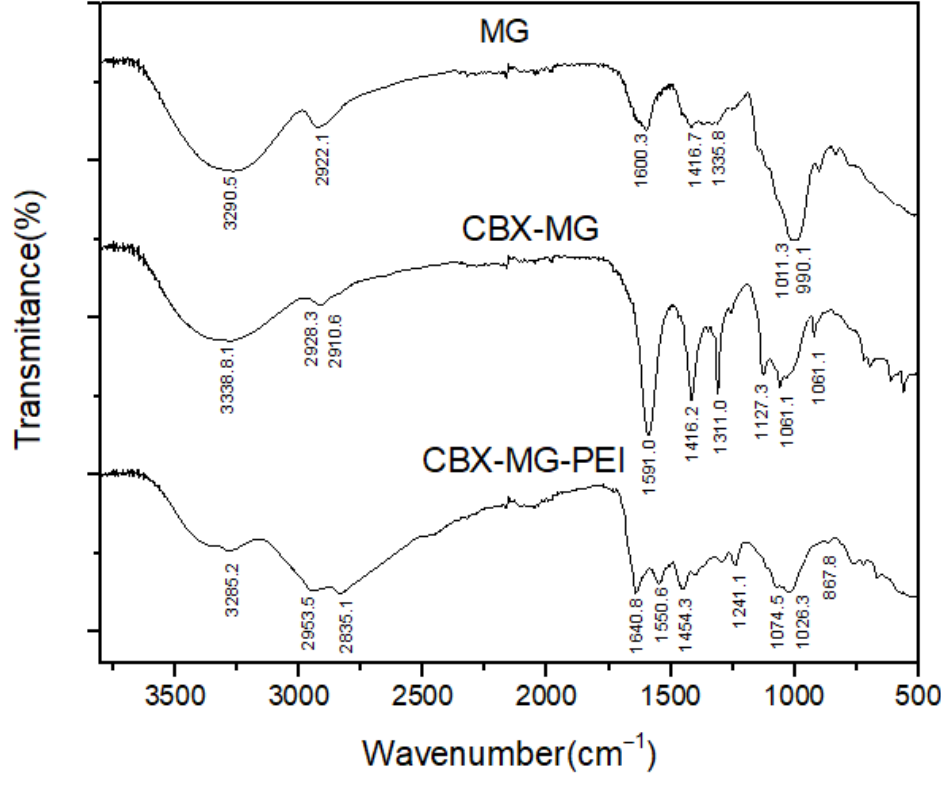
Figure 2. FTIR spectra of MG, CBX-MG and CBX-MG-PEI.